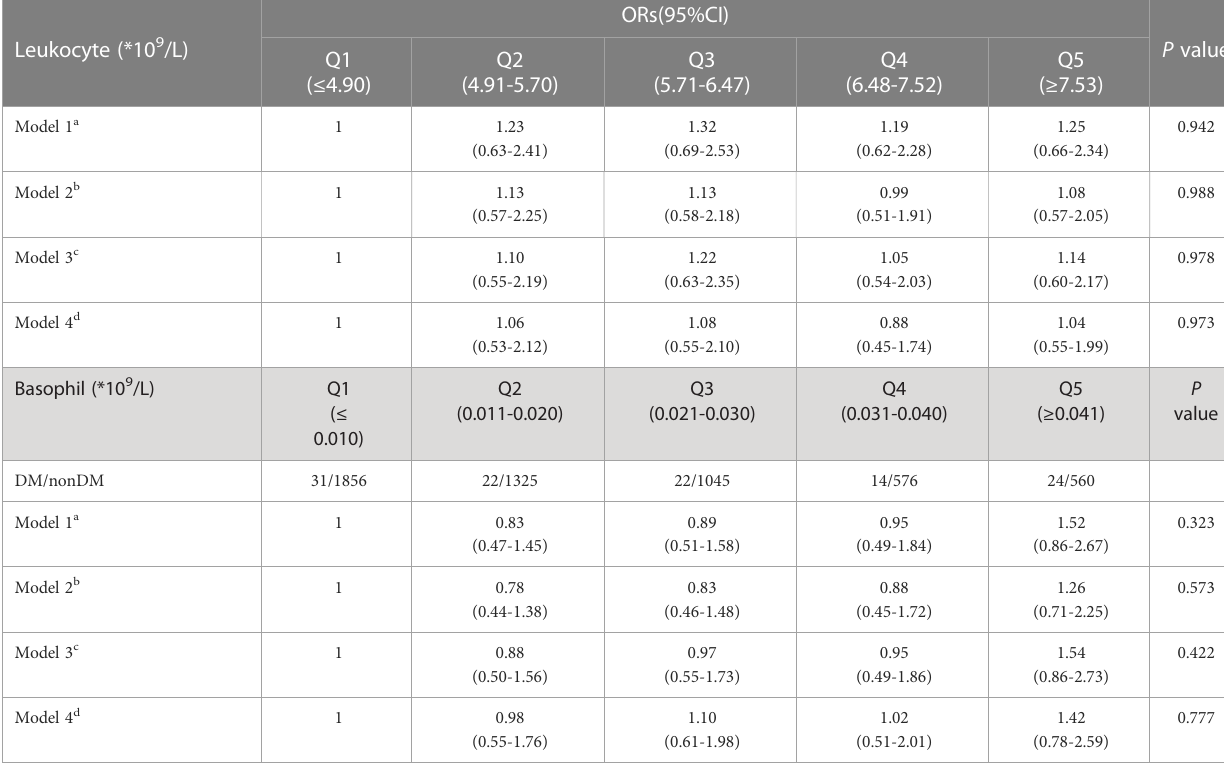
count (Table 3). Time-dependent ROC curves were plotted according to different follow-up times to estimate the predictive diagnosis of T2D by the four indicators mentioned above. The analysis revealed that the follow-up time of these 4658 (5013-355) participants ranged from 4 months to 36 months, with a mean follow-up time of 12 months, with new cases occurring in the follow-up population from 10 months to 36 months. The indicators had some predictive value for T2D, except for 10 and